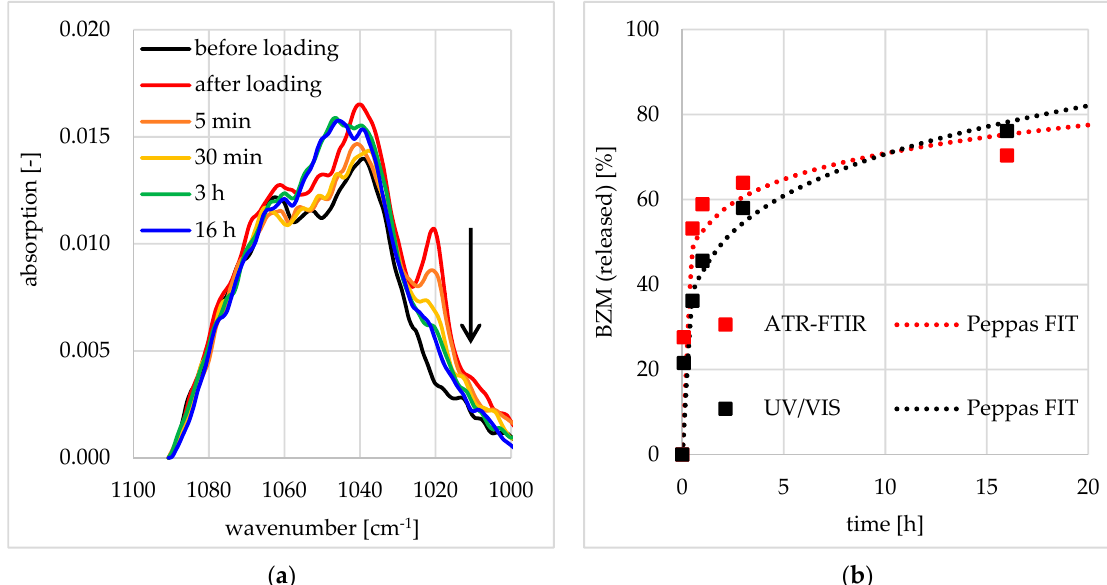
Figure 13. ATR-FTIR spectra on the release of BZM from PEC nanoparticles (NP) coatings deposited at the germanium model substrate ( a ) and the release kinetics found on ATR-FTIR in comparison to UV/VIS data ( b ).